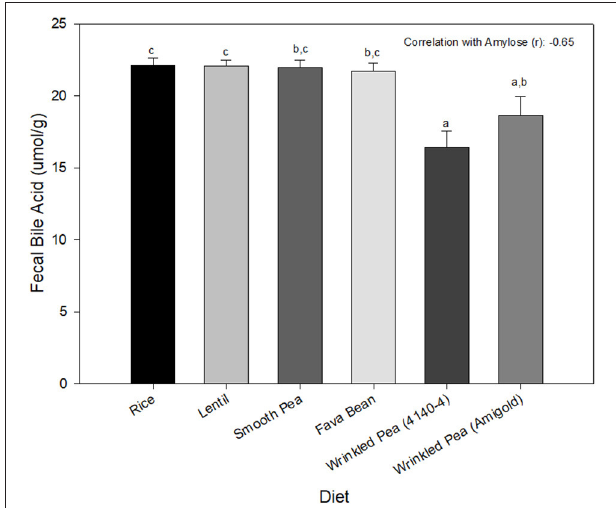
FIGURE 2 | Fecal bile acid content from dogs after 7 days of feeding each test diet. Diets are listed in order of increasing fiber and amylose content from left to right. Data is shown as Mean ± SEM; n = 8 dogs. Different letters indicate significant differences using Tukey’s post-hoc analysis ( P < 0.05) after 1-Way Repeated Measures ANOVA.